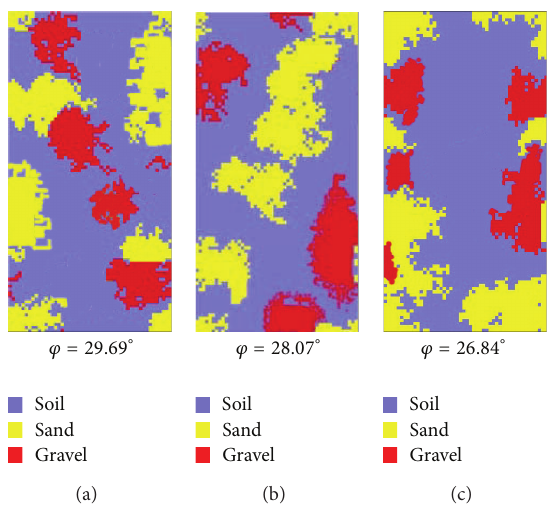
Figure 6: HHC-Granular model generated different initial fabric of grain of FS.G.